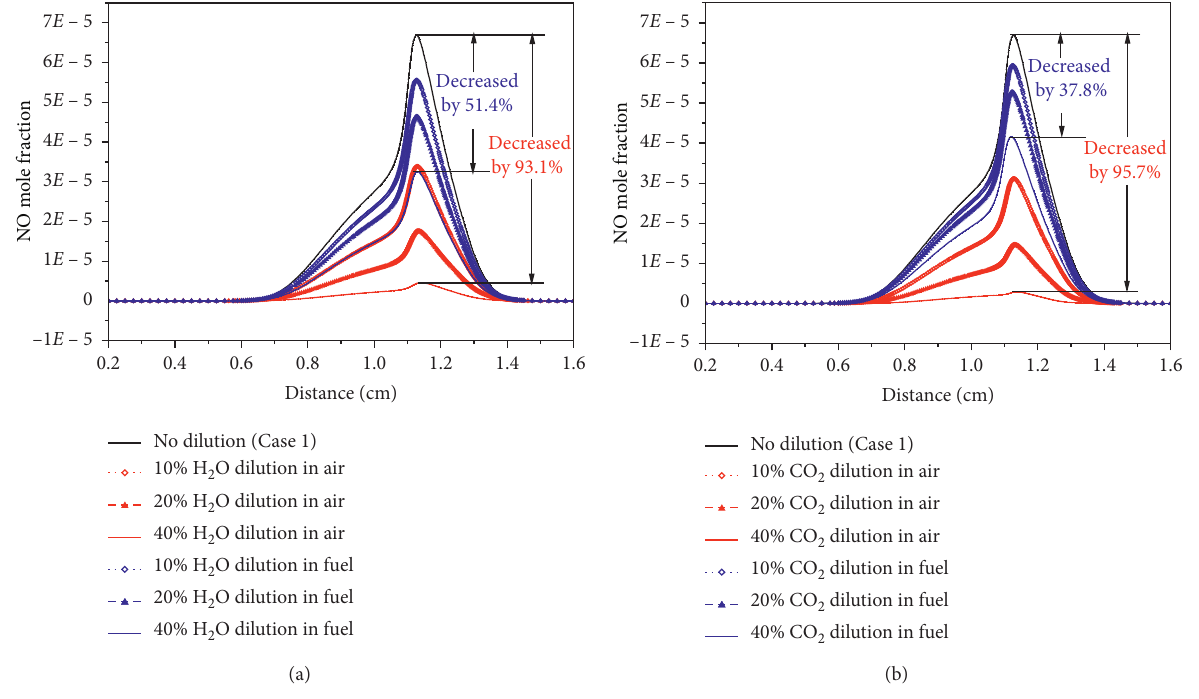
Figure 5: Distributions of NO mole fraction in CH 4 /air counterflow diffusion flames as a function of distance from the fuel nozzle with H 2 O, (a) and CO 2 , (b) dilution: a s � 50s − 1 , L � 2 cm,